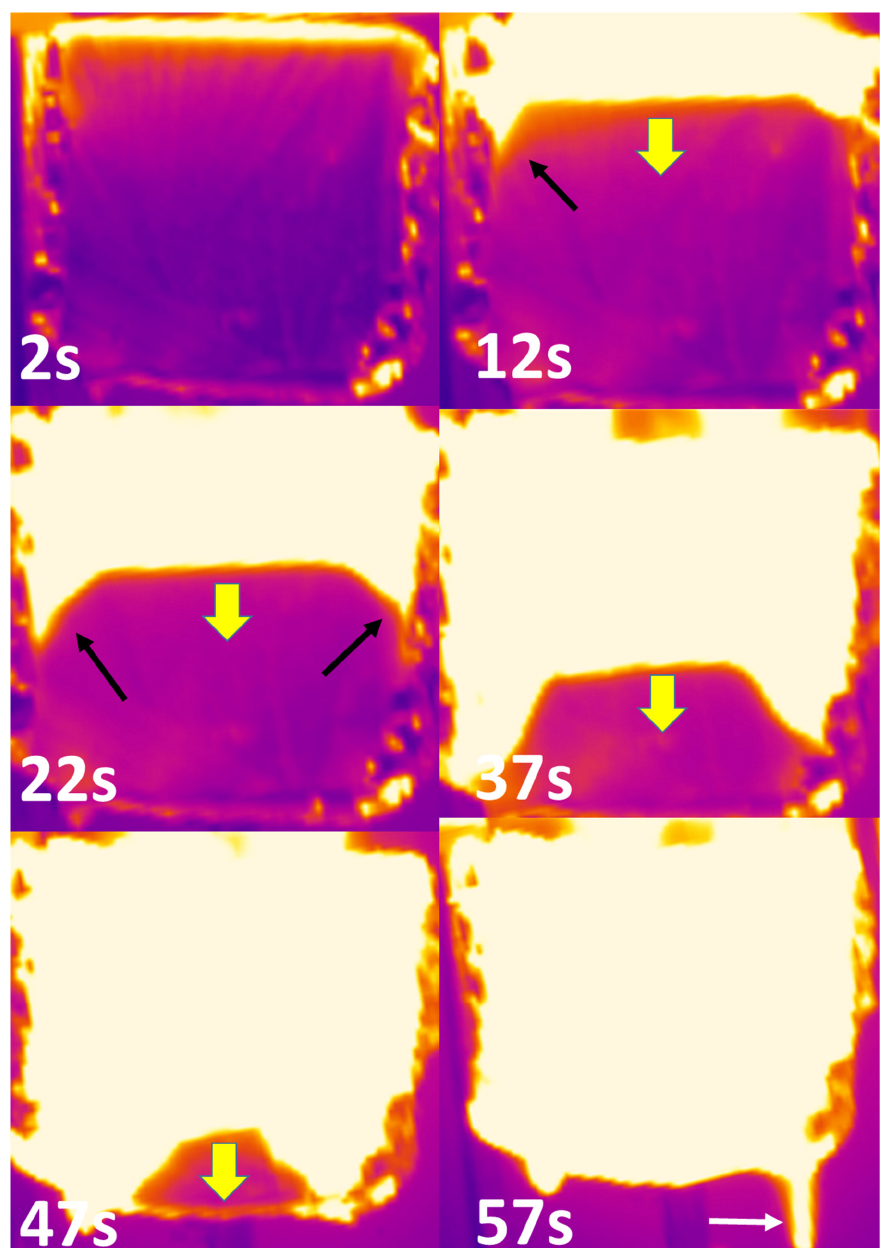
Figure 8. Some pictures from the IR camera for the HD foam collapse during the cone calorimeter test at 35 kW/m 2 (sample thickness 10 cm).